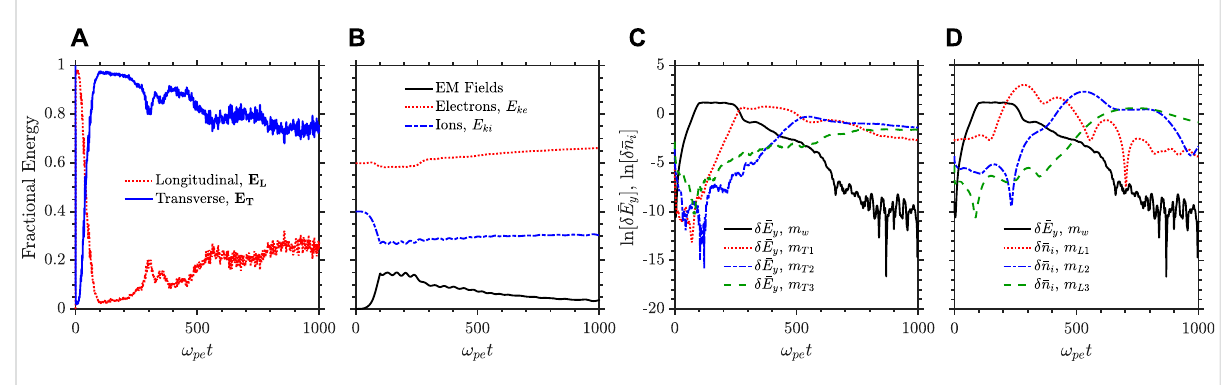
Analysis of energy transfer and wave growth during thetriple decay for δ B w / B 0 =0.103 (A) Fractional electric fi eld energy that is contained in the longitudinal electric fi eld (red dotted curve) and transverse electric fi eld (blue solid curve) (B) Fractional energy of the electromagnetic fi elds (black solid curve), electron kinetic energy (red dotted curve), and ion kinetic energy (blue dash-dotted curve) (C) and (D) growth of the parametric decay modes for the daughter whistler and ion acoustic waves, respectively. The solid black curve is the pump whistler, the red dotted curve is the primary decay, the blue dash-dotted curve is the secondary decay, and the green dashed curve is the tertiary decay.